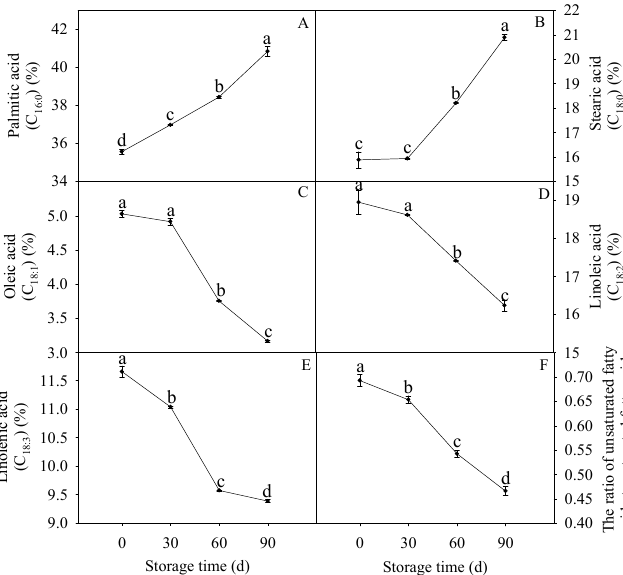
Figure 5. Changes in relative contents of palmitic acid ( A ), stearic acid ( B ), oleic acid ( C ), linoleic acid ( D ), and linolenic acid ( E ), and the relative contents of unsaturated fatty acids (USFA) to saturated fatty acids (SFA) ( F ) in postharvest pumelos during storage at 25 °C. Each data point was shown as the mean ± standard error (SE). Different letters indicated significant difference ( p < 0.05).